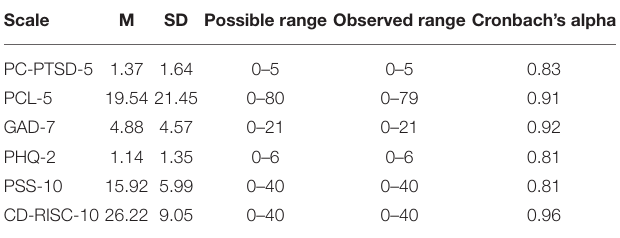
TABLE 2 | Normative data for the psychological